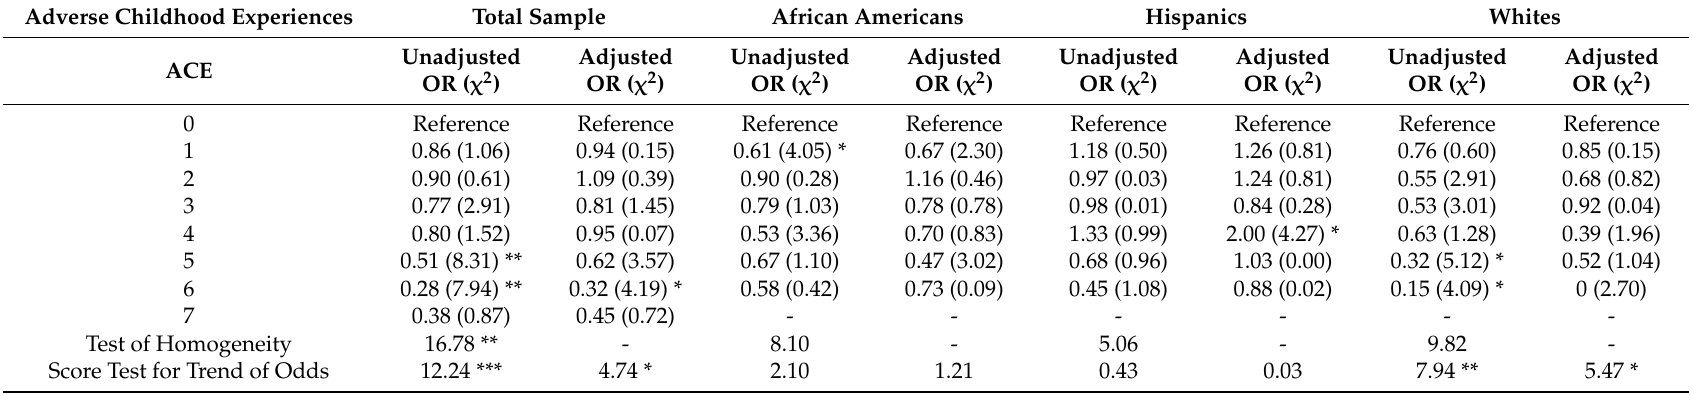
Table 1. Table of odds for homicide as commitment offense. ACE, Adverse Childhood Experiences. OR, Odds Ratio. Adverse Childhood Experiences